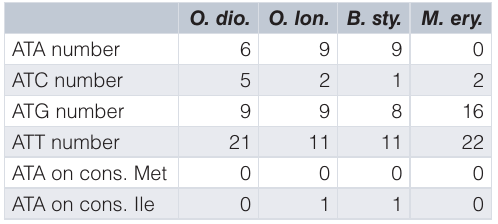
Table 2. ATN codons in Cob in Oikopleuridae.